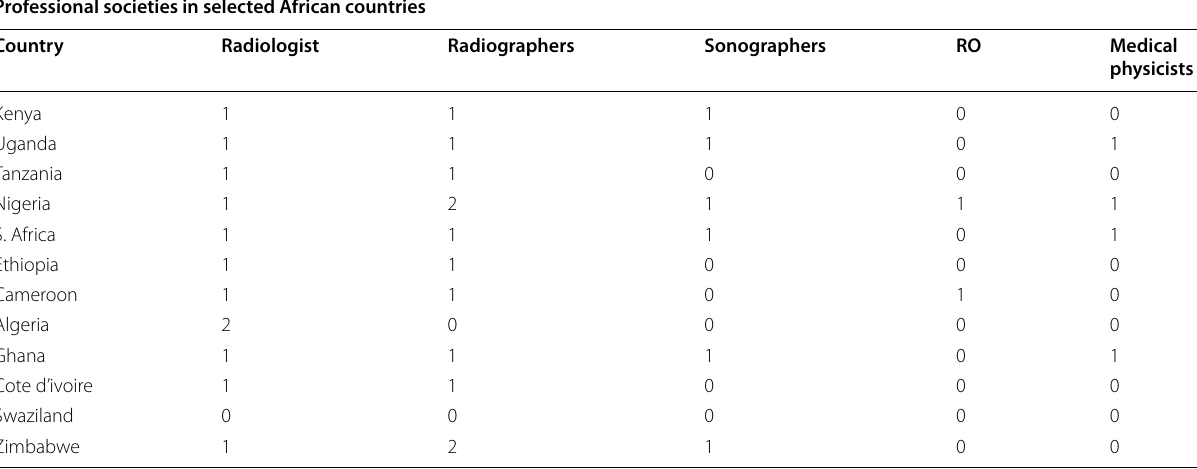
RO-Radiation Oncologists